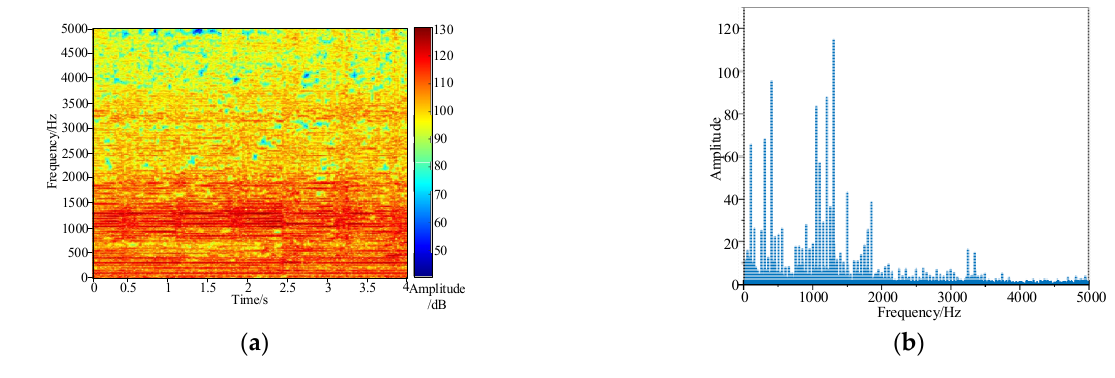
Figure 6. ( a ) Acoustic time–frequency spectrum; ( b ) spectrum distribution.